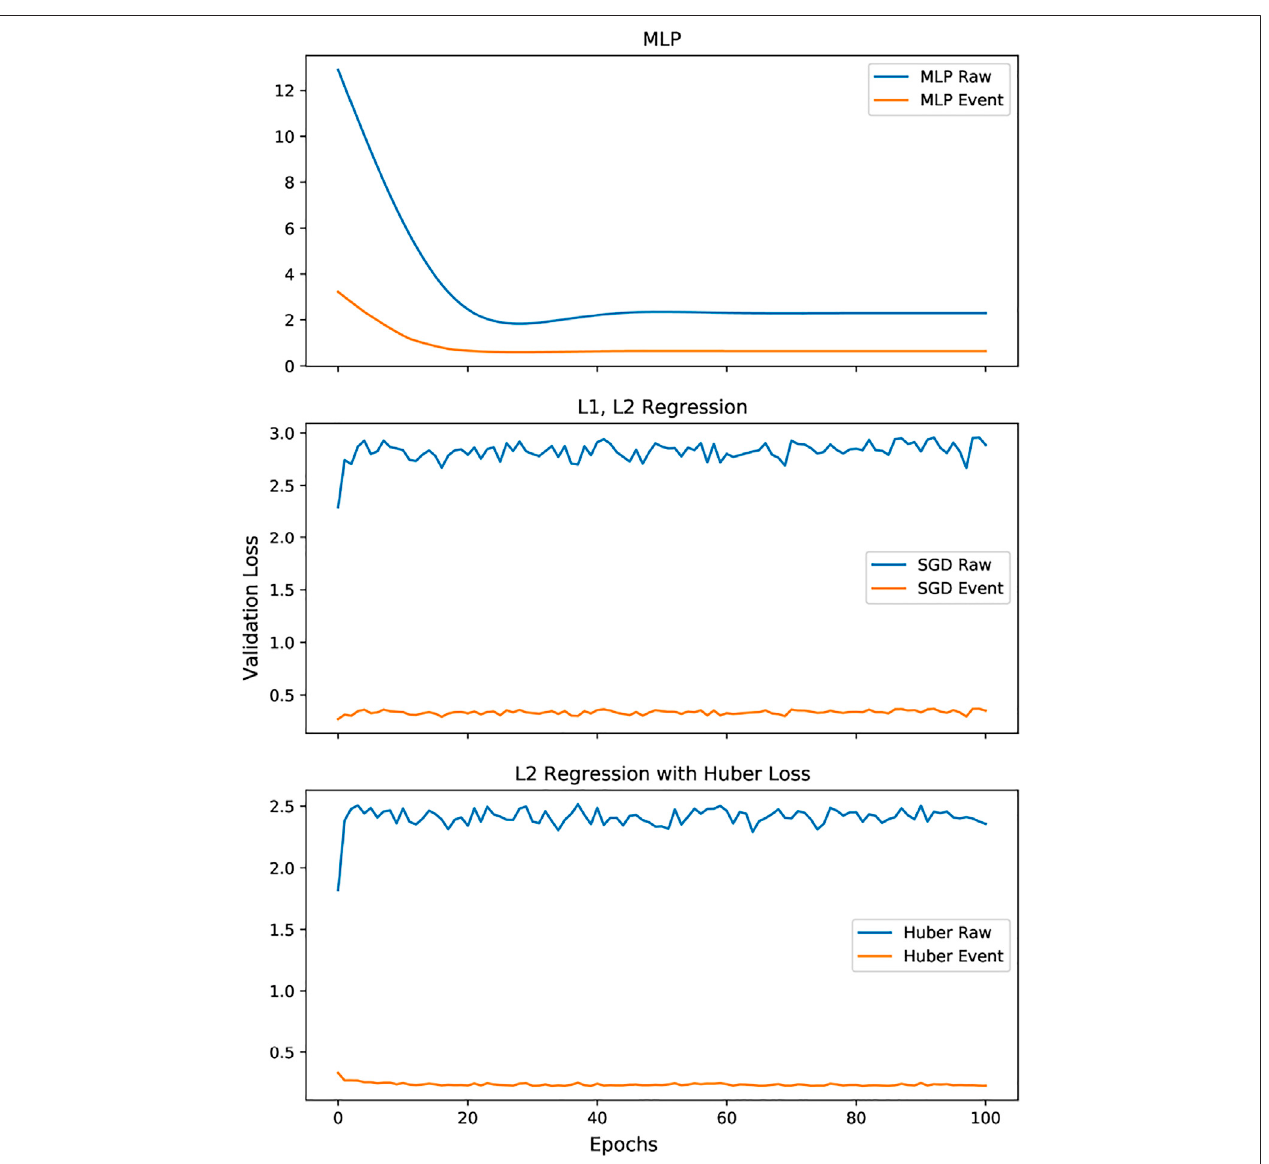
FIGURE 8 | Comparing various force-area regression methods for raw vs. event data.